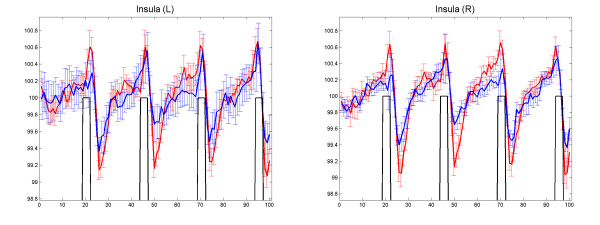
The average BOLD signal extracted from the bilateral insula that showed significantly longer delay in Figure 3. The BOLD signal of the HA group was slower to reach peak in response to the maximum inspiration task.